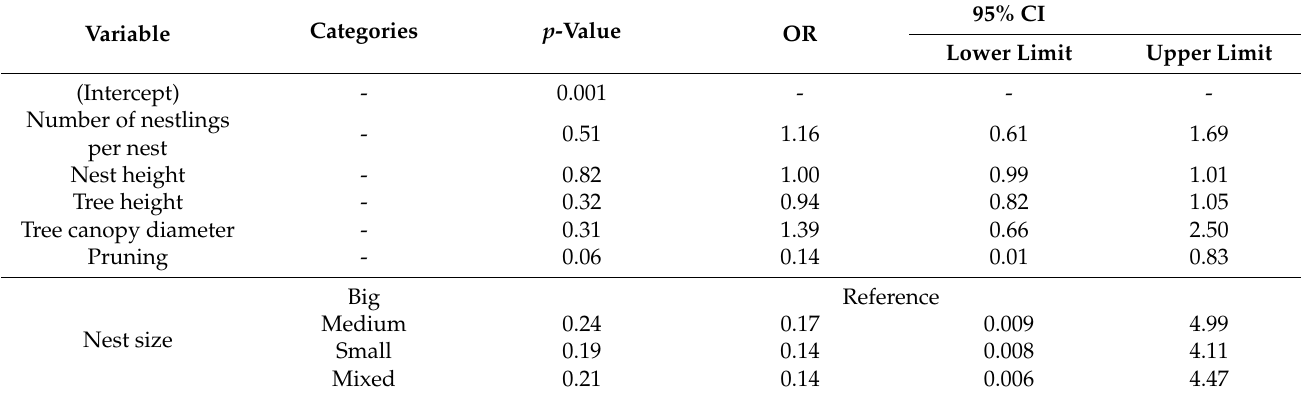
Table 2. Results from the multivariable logistic regression analysis. Category, p -value, odds ratio (OR), and 95% confidence interval (CI) lower and upper limits are reported for the variables that were retained in the model showing an association or relevance on the positivity to Cryptosporidium spp. on Monk Parakeet samples.